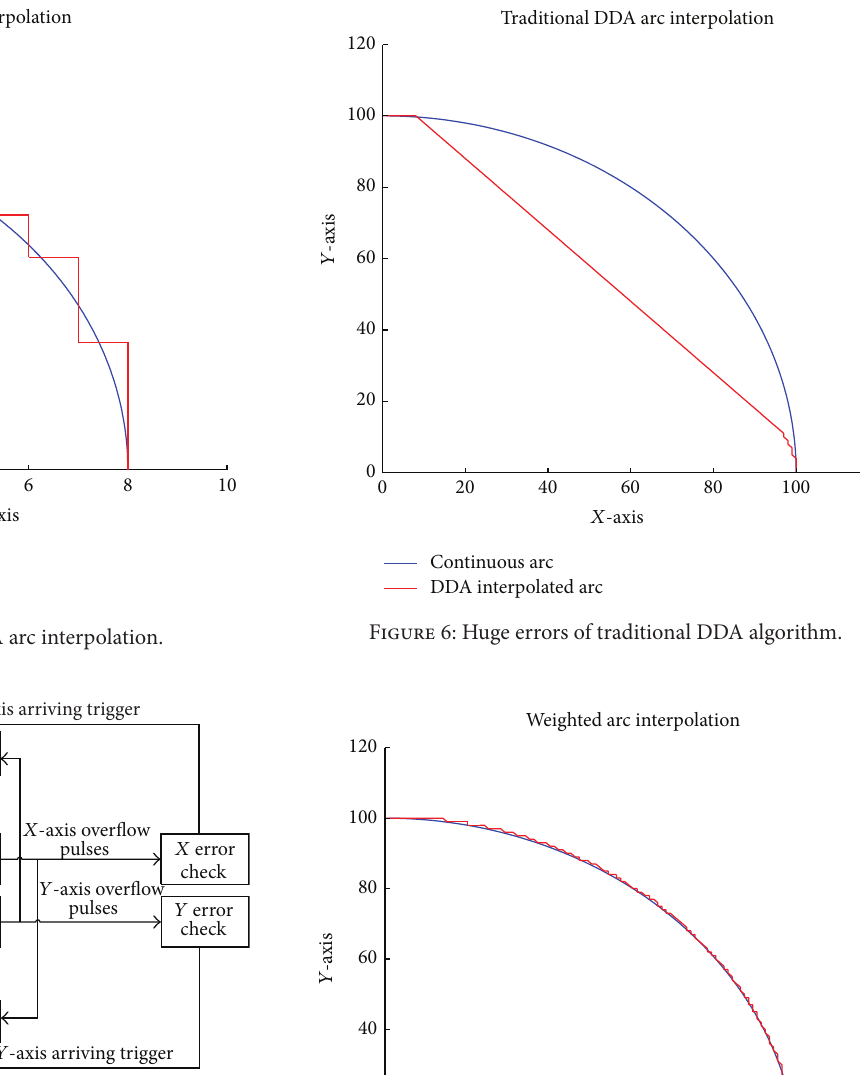
Figure 5: Logic structure of traditional DDA arc interpolation.